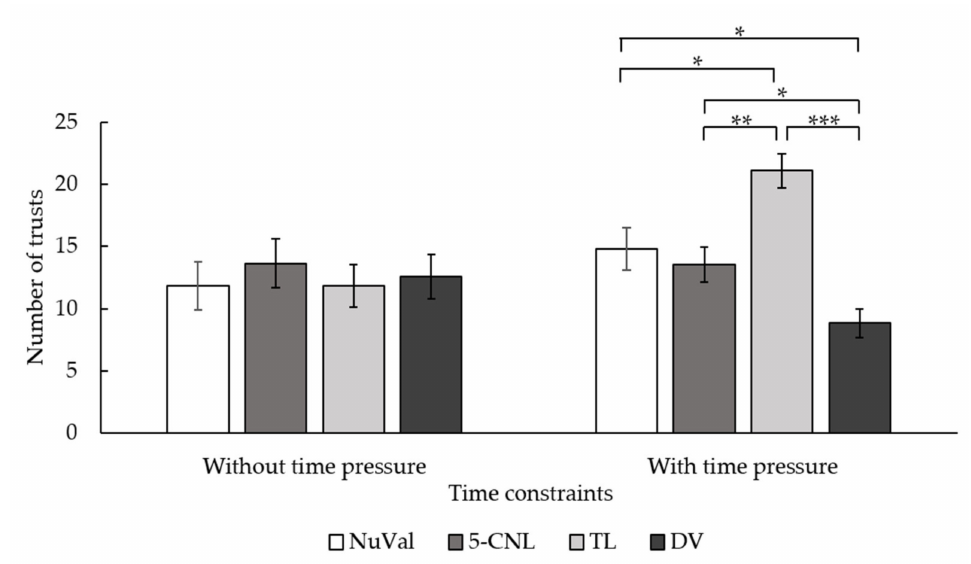
Figure 7. Interaction between the time constraints and types of nutrition labels in terms of the number of times for choosing nutrition label types in Experiment 2. The error bar stands for the standard error. * represents that p < 0.05. ** represents that p < 0.01. *** represents that p <